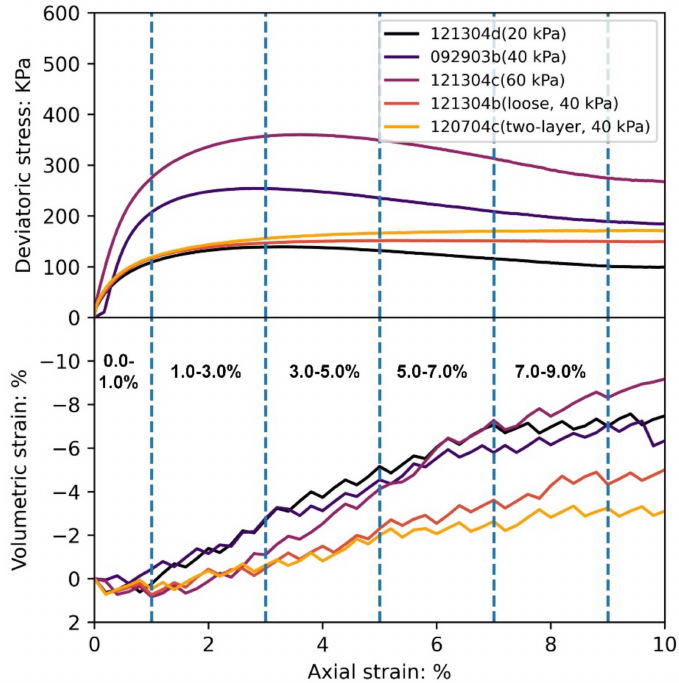
Figure 7. Strain windows for kinematic analyses: 0.0–1.0%, 1.0–3.0%, 3.0–5.0%, 5.0–7.0%, and 7.0–9.0% of axial strain.